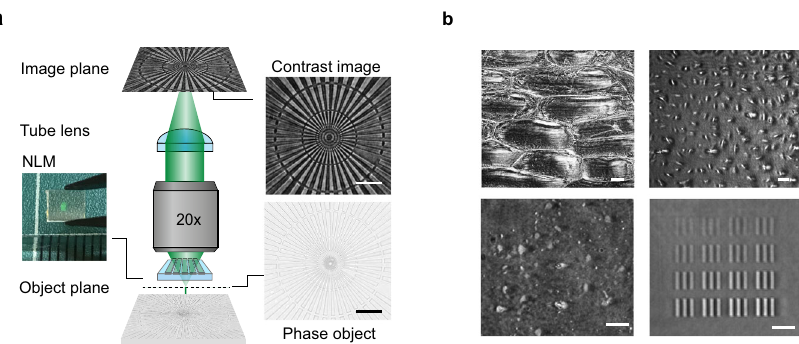
Fig. 1| Anonlocalmetasurface(NLM)patternedonamicroscopeslideenables phase contrast imaging. a A schematic showing how a classic bright fi eld microscopecan betransformed into a phase imaging setup simply by inserting an NLM on top of the phase object. The fl at optical component, a commercial phase object and the corresponding phase contrast image are shown next to the